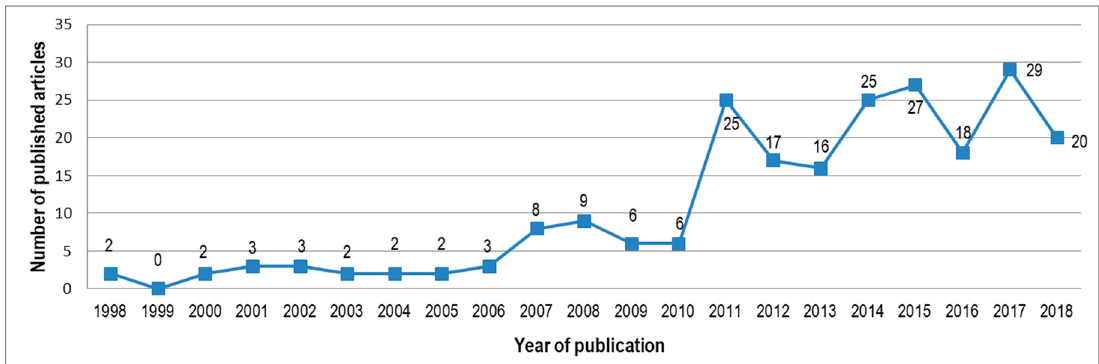
Figure 2. Classification of articles by year of publication.